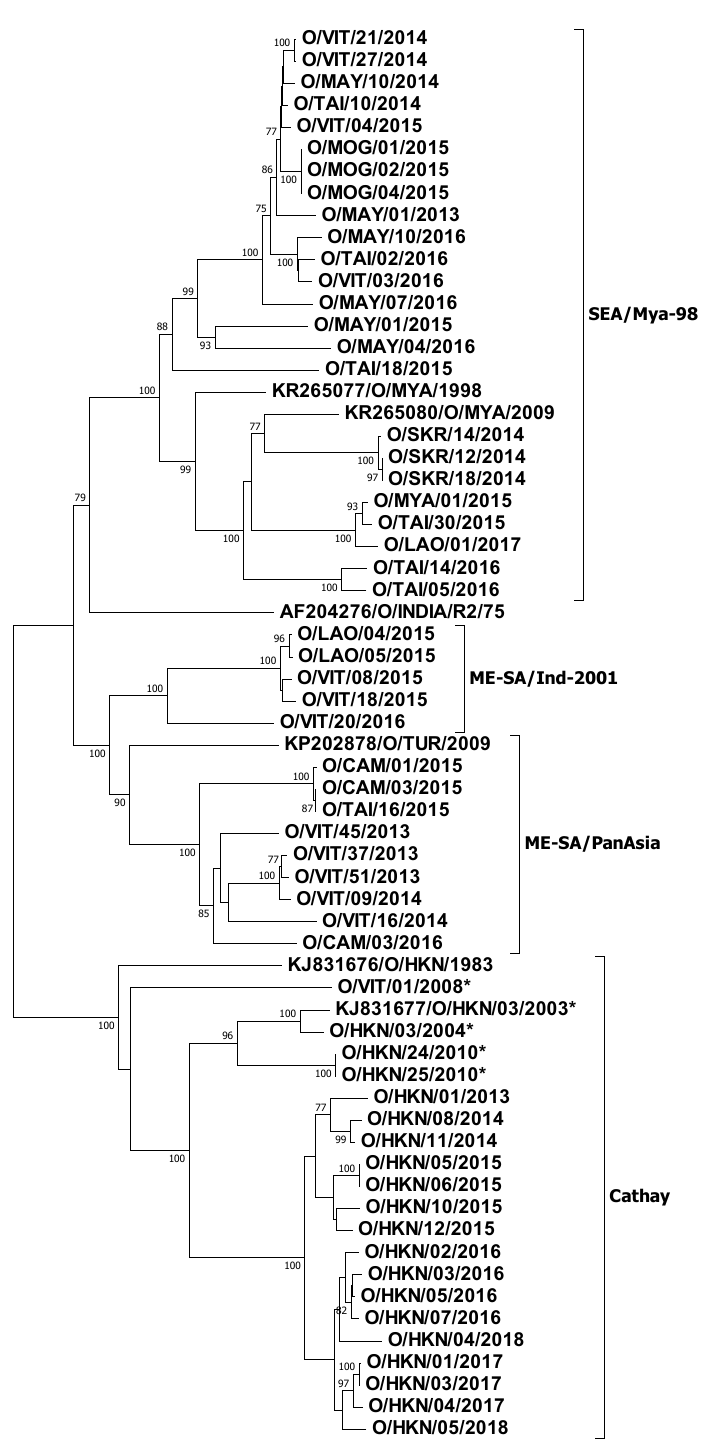
Figure 2. Neighbor-joining phylogenetic tree (P1) of the Southeast Asian serotype O viruses. The lineages/sub-lineages defined by WRLFMD on the basis of VP1 sequences are shown in the figure. The sequences with an asterisk at the end of their name are taken from our previous study [12] and included in the analysis to investigate the molecular basis of the antigenic drift in case of the Cathay topotype viruses. The GenBank accession numbers (MZ851285–MZ851338) of the se- quences generated in this study are provided in Table S1. The tree was generated using MEGA 6.0 software